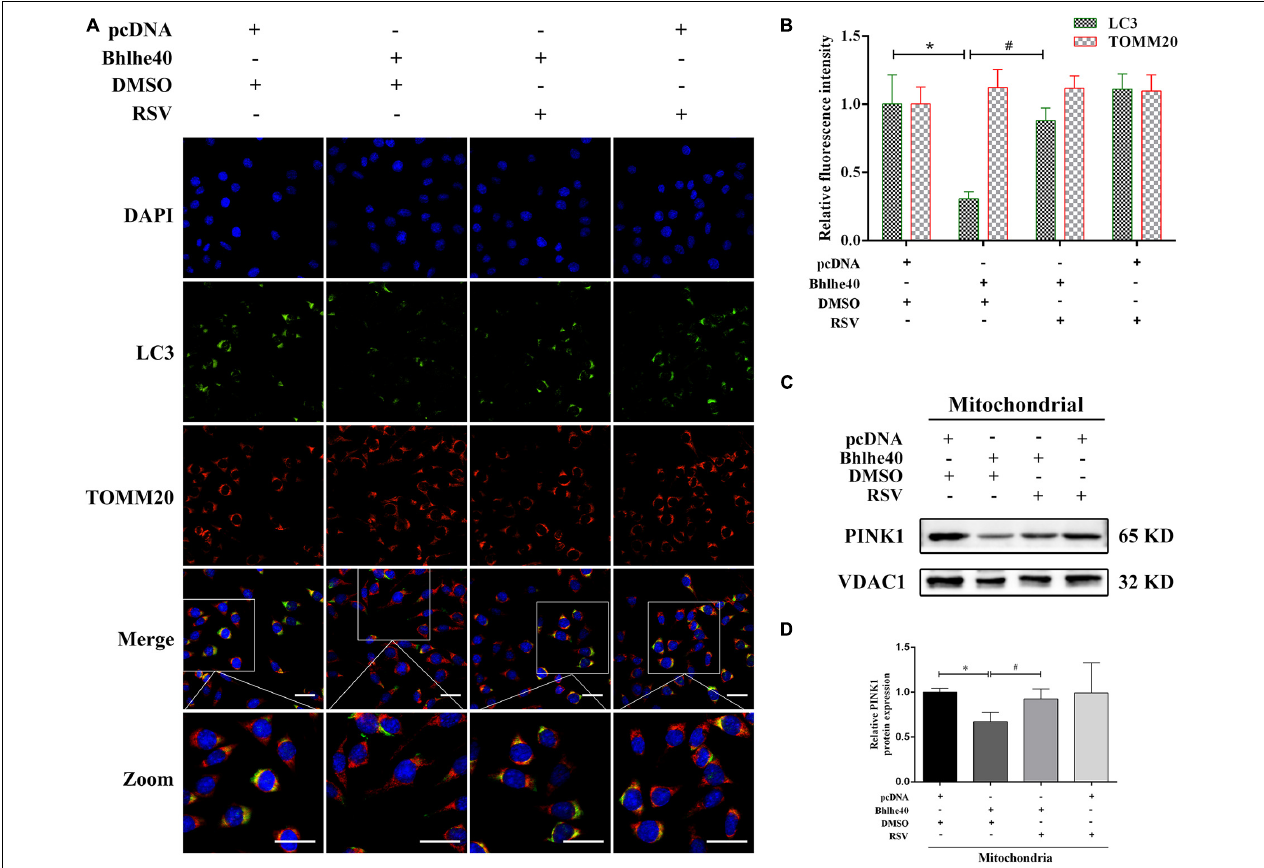
FIGURE 8 | The Sirt1 activator RSV attenuated mitophagy inhibition caused by Bhlhe40 in C17.2 cells. (A) C17.2 cells were double immunofluorescence-stained, with LC3-labeled autophagosomes (green) and TOMM20-labeled mitochondria (red). Scale bar = 25 µ m. (B) Relative fluorescence intensities of LC3 and TOMM20 in each group ( n = 3). Results are expressed as the mean ± SD. * p < 0.05 vs. pcDNA + DMSO group; # p < 0.05 vs. Bhlhe40 + DMSO group. (C) Western blot analysis of PINK1 in mitochondria isolated from C17.2 cells treated with different combinations of pcDNA, Bhlhe40, DMSO, and RSV. (D) Quantitation of PINK1 protein ( n = 3). Results are expressed as the mean ± SD. ∗ p < 0.05 vs. pcDNA + DMSO group; # p < 0.05 vs. Bhlhe40 + DMSO